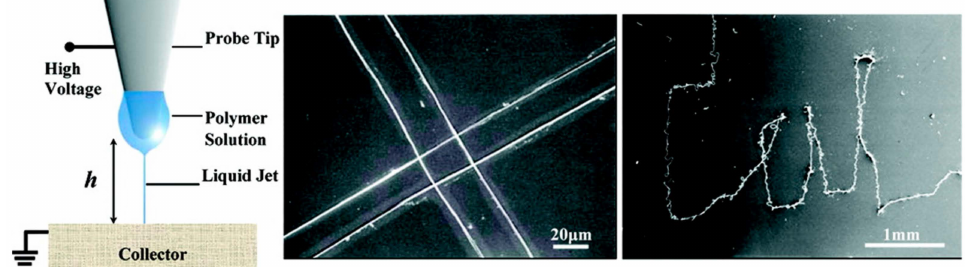
Figure 11. A schematic representation of the near field electrospinning process and the fibers obtained after electrospinning. Sun and colleagues used this technique to demonstrate the fabrication of continuous nanofibers with a desired pattern using a Tungsten tip. Reprinted with permission from [52], American Chemical Society, 2006.